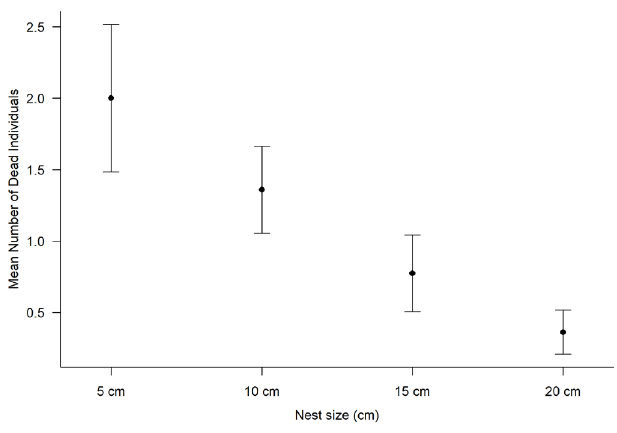
Fig 2 . Mean number of dead immatures of Centris analis in trap- nests of different